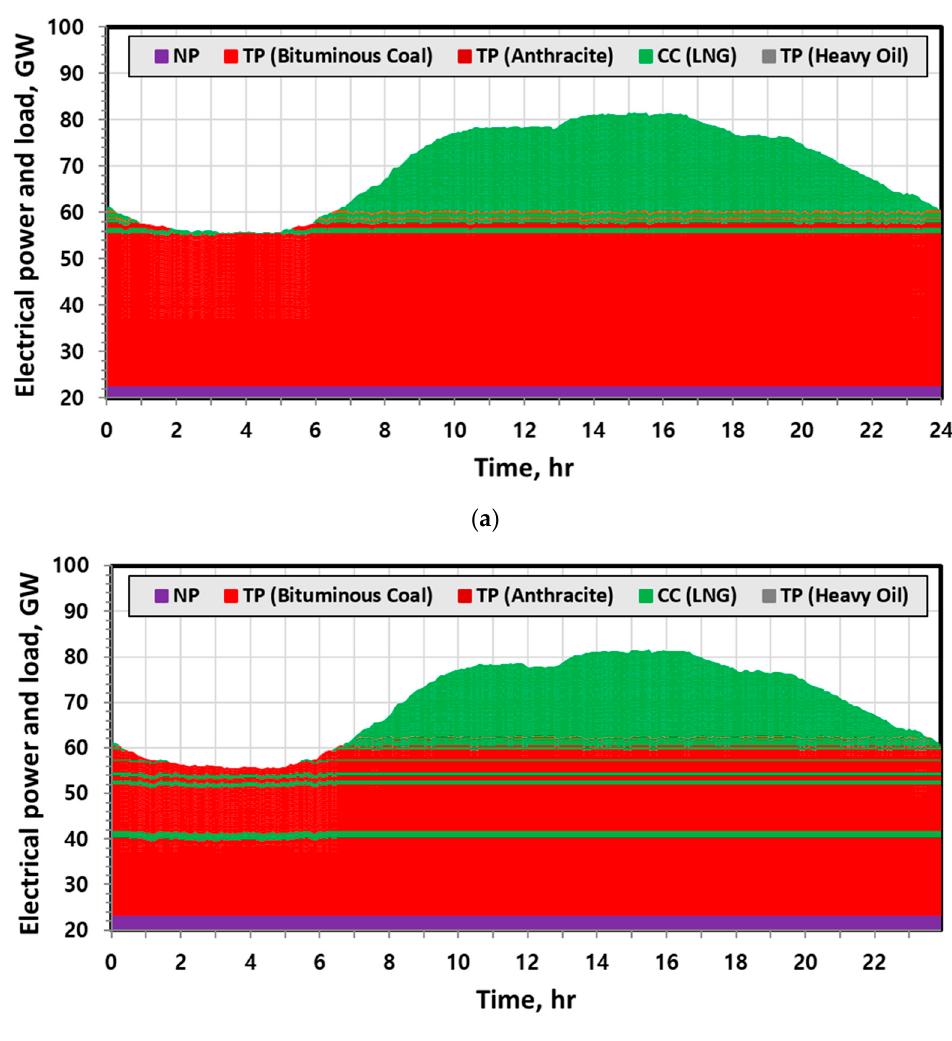
Figure 5. The 24-h Simulation result of electric power supply and demand by base-point tracking Figure mode (December 2019); ( a ) Economic load dispatch (EcoLD); ( b ) Environmental load dispatch (En- vLD).